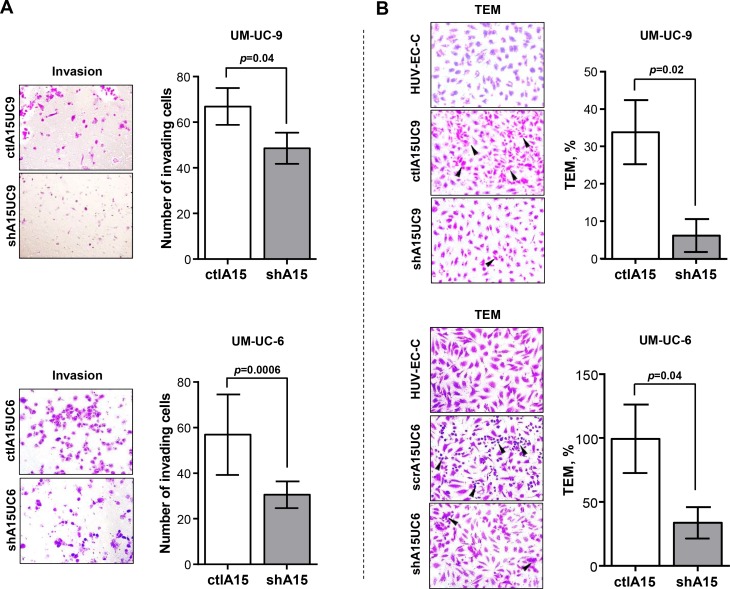
Knockdown of ADAM15 decreases bladder cancer cell invasion and transmigration through vascular endothelium.A) Extent of MatrigelTM invasion of UM-UC-9 and UM-UC-6 bladder cancer cells expressing empty vector and scrambled ADAM15 sequences (ctl) and short hairpin RNA (shA15). The bars indicate mean invading cells ± SD (n = 3). The data are representative of 1 of 5 UM-UC-9 or 1 of 3 UM-UC-6 independent experiments. A representative 20X image of each condition is shown. B) Transendothelial migration assay revealed reduced transmigration through an endothelial HUV-EC-C monolayer of shA15UM-UC-9 and shA15UM-UC-6 cells when compared with control cells (ctl). Bars represent mean ± SEM (N = 3). A representative 20X image of each condition is shown.